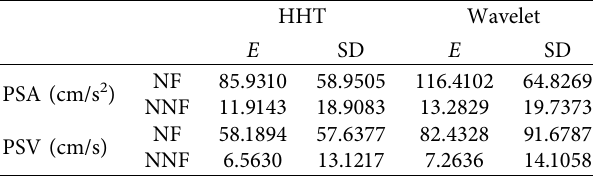
Table 4: The velocity and acceleration